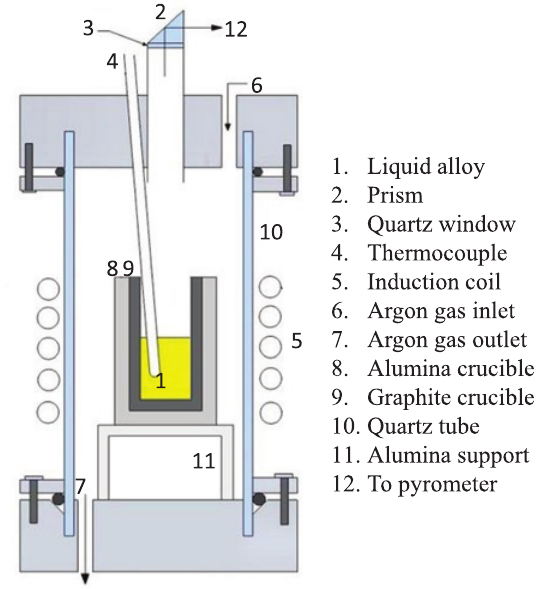
Fig. 3: Schematic diagram of the induction furnace system for preparation of silicon-iron alloys